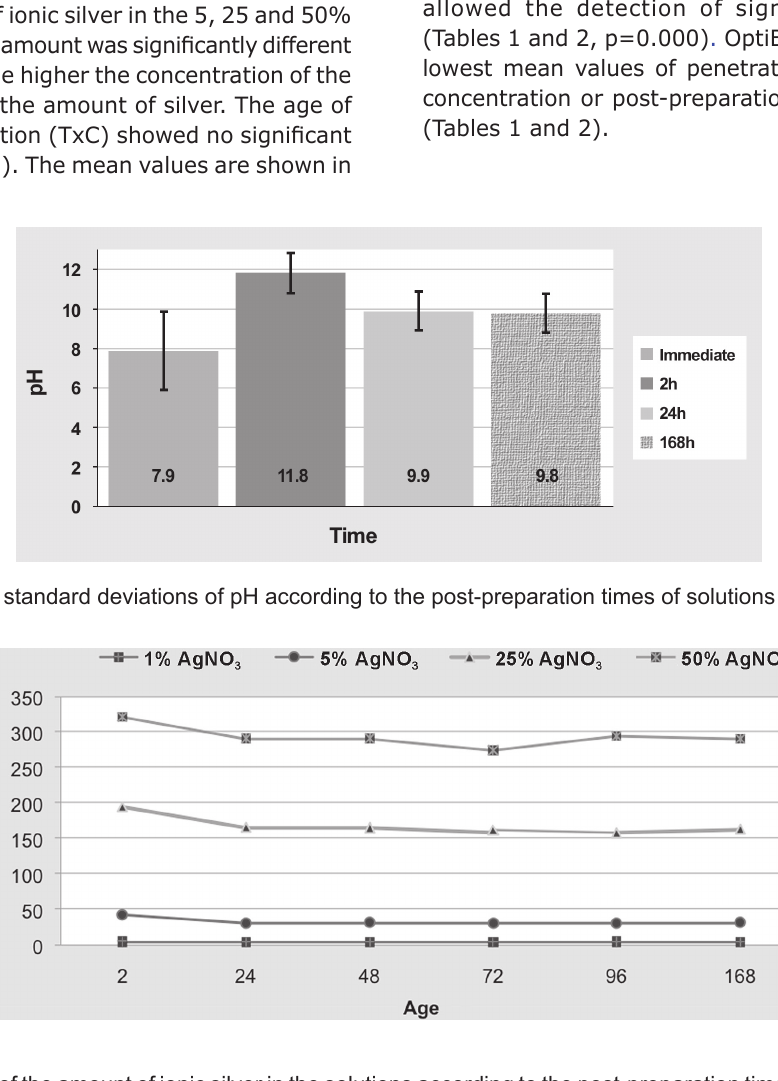
Table 1- Mean values and standard deviations (mm) of tracer penetration in permanent teeth regarding adhesive systems according to concentration and post preparation time of solutions as well as statistical significance* Concentration 25% Time 2 h